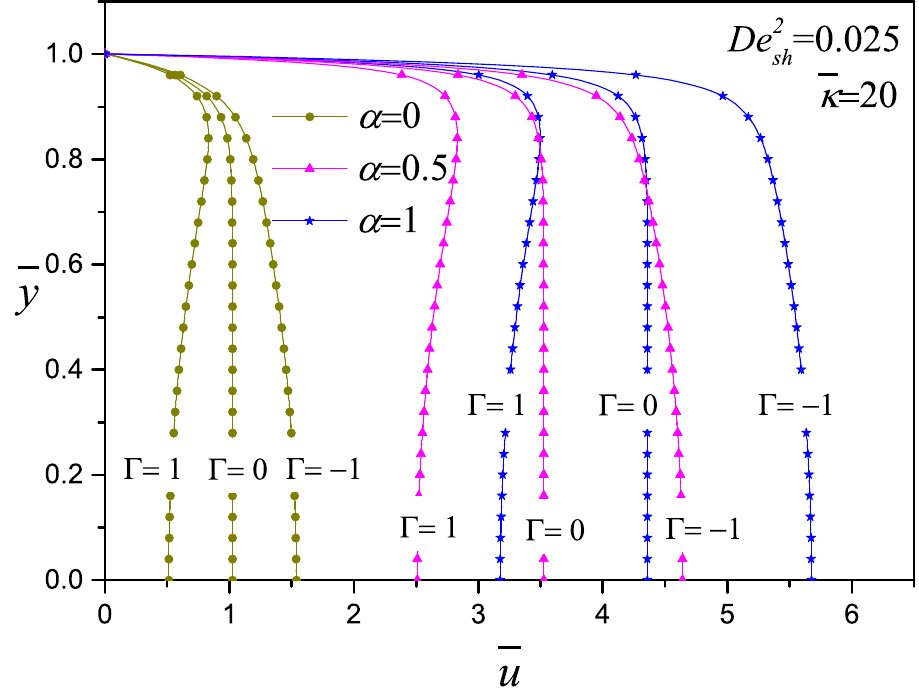
Figure 5. Effect of the pressure gradient ( Γ = 1,0, − 1 ) on the velocity profile with κ = 20 and = 0.025 for the codeformational ( α = 0 ) , mixture ( α = 0.5 ) and corotational ( α = 1 ) models. De 2 sh